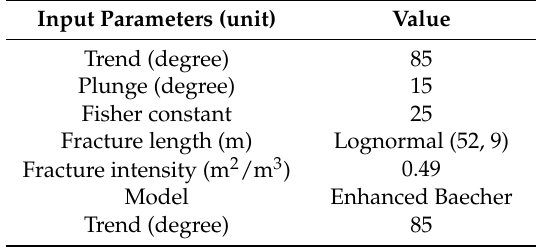
Table 2. Natural fracture properties of the synthetic reservoir.